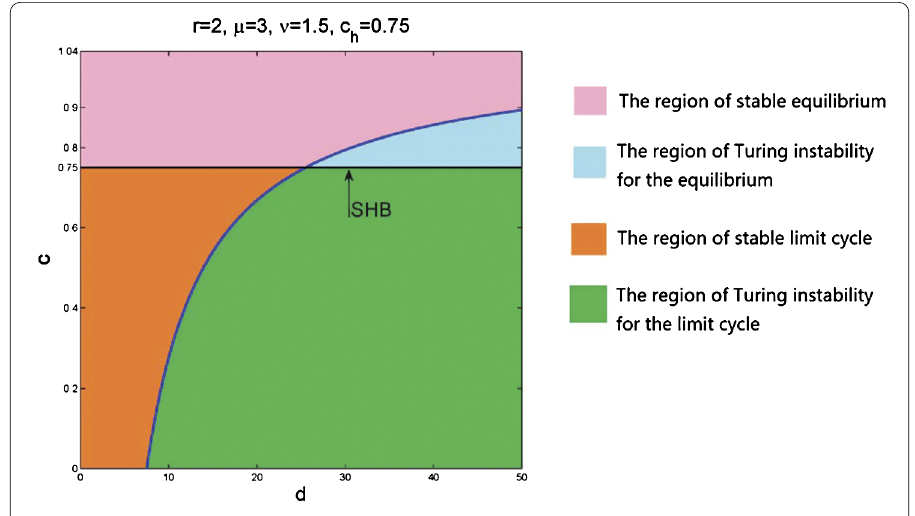
Figure 15 The regions for Turing patterns of system (3)